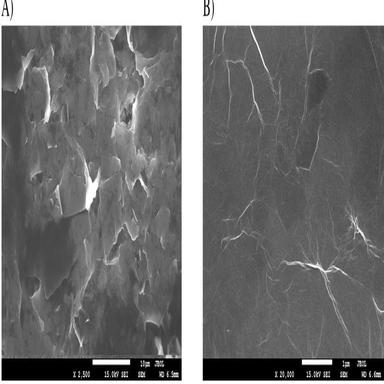
SEM images of GO in the structure of the film composed of PEI and GO. Image size: (A) - 10 μm × 10 μm with magnification 2500×, (B) - 1 μm×1 μm and magnification 20,000×.